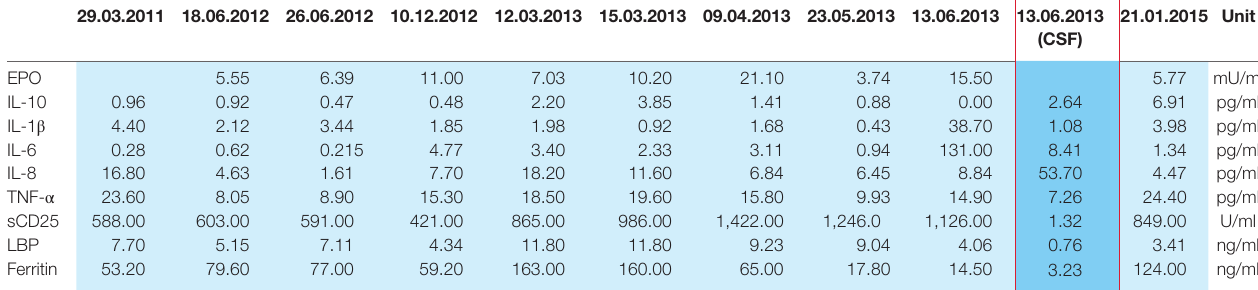
taBLe 2 | Plasma cytokines and CSF cytokines (red framed) of the patient in 2011–2015 based on research done by Prof. Dr. E. Marion Schneider, Experimental Anesthesiology Section, University Clinic Ulm, 89075 Ulm,